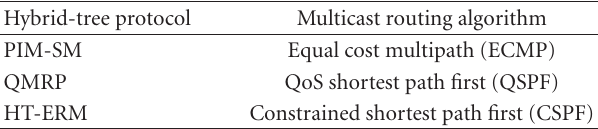
Table 2: Hybrid multicast scheme with routing